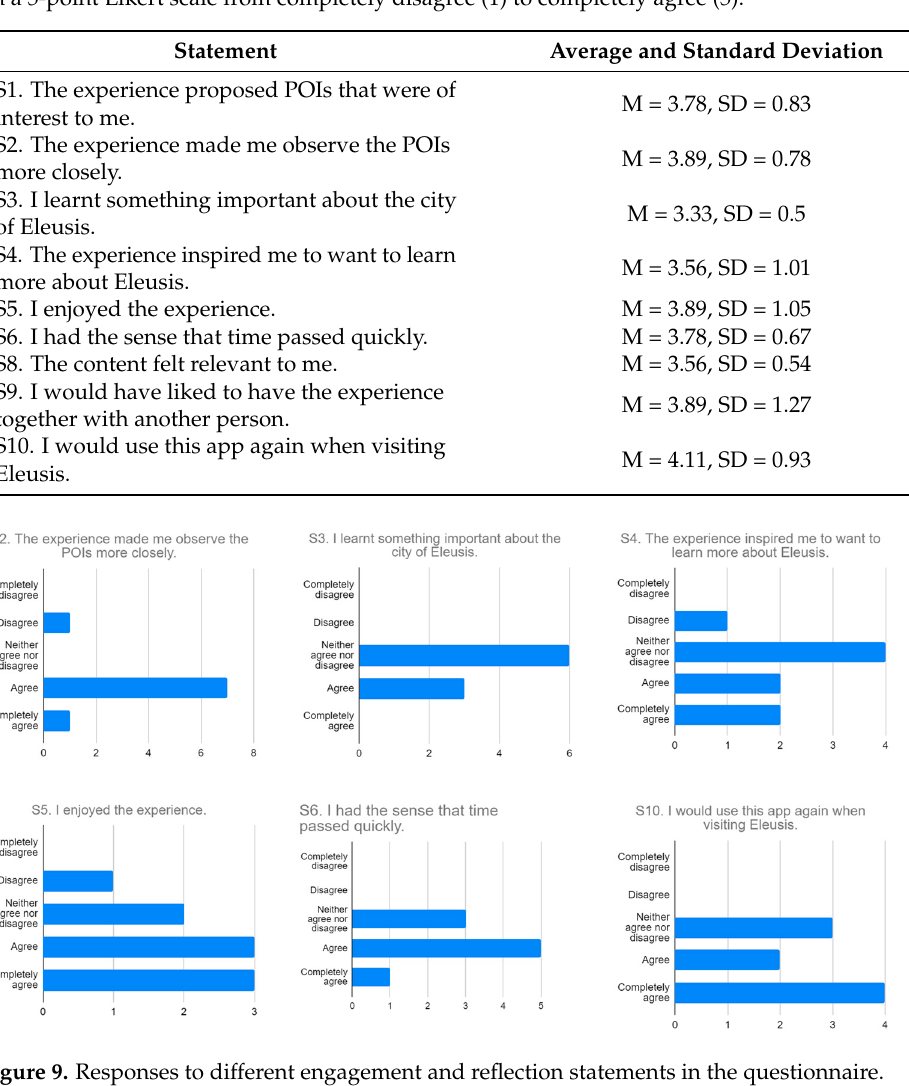
Table 5. Average score and standard deviation for the questionnaire statements. The statements were on a 5-point Likert scale from completely disagree (1) to completely agree (5).